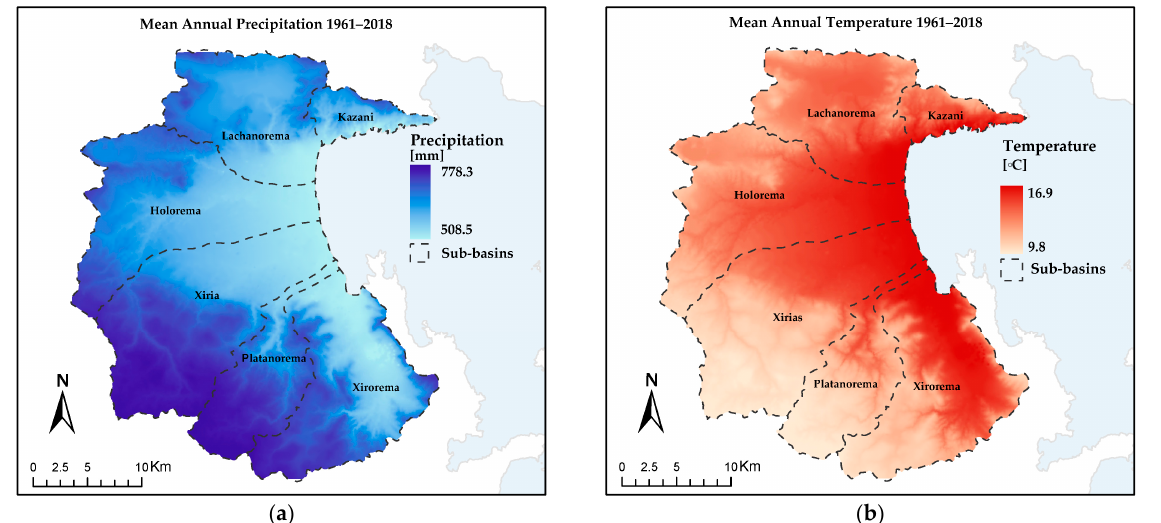
Figure 6. Spatial distribution of ( a ) mean annual precipitation and ( b ) mean annual temperature for the years of 1961–2018.